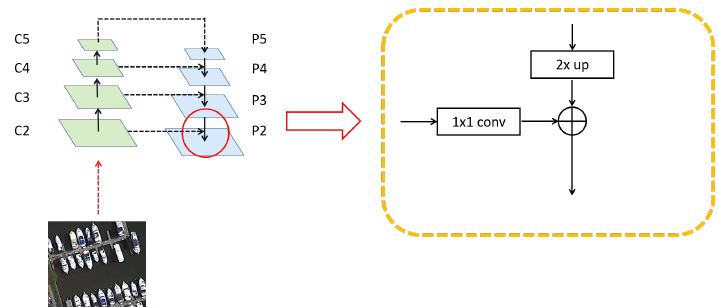
Figure 8. The construction process for the feature pyramid.